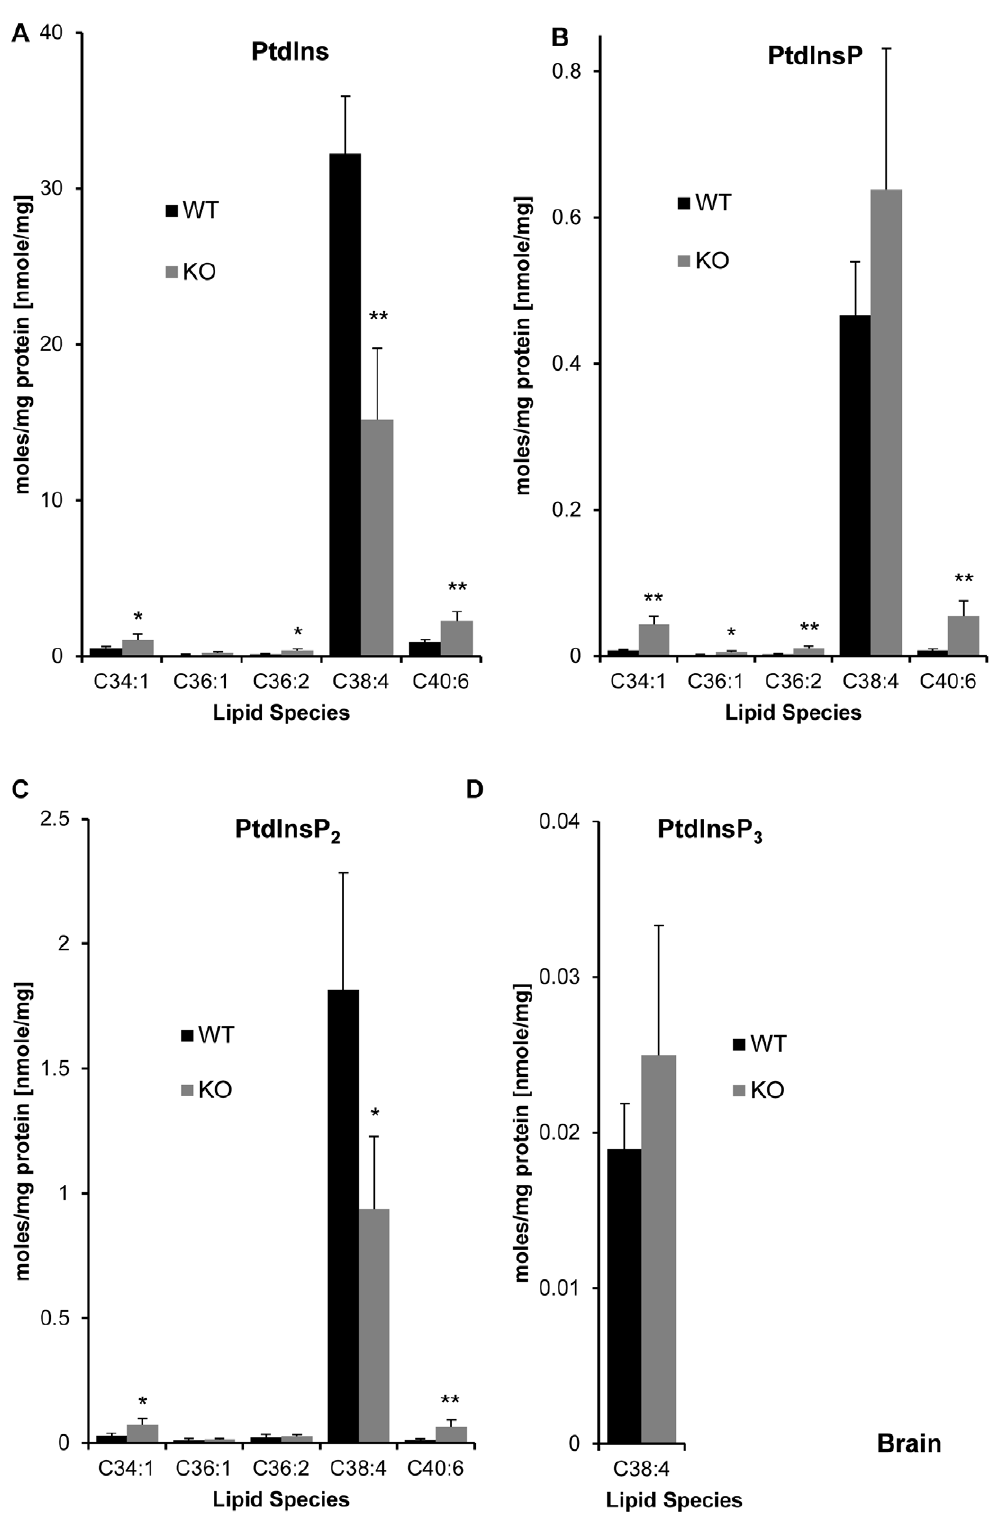
Figure 6. Effect of LPIAT1 knockout on brain phosphoinositide lipid molecular species. Brains from 13 day old littermates expressing (LPIAT1 + / + (WT)) or lacking (LPIAT1 2 / 2 (KO)) LPIAT1 were homogenised and lipid extracted from 0.5 mg wet weight as described in Materials and Methods. Targeted molecular species of PtdIns ( A ), PtdInsP ( B ), PtdInsP 2 ( C ) and PtdInsP 3 ( D ) were detected by MRM mass spectrometric analysis as described in Materials and Methods. Data are expressed as moles/mg protein, normalized to relevant internal standards. Shown are mean 6 SD, n=4 for both WT and KO. Data were analyzed by T-test. *p # 0.05, **p # 0.005.